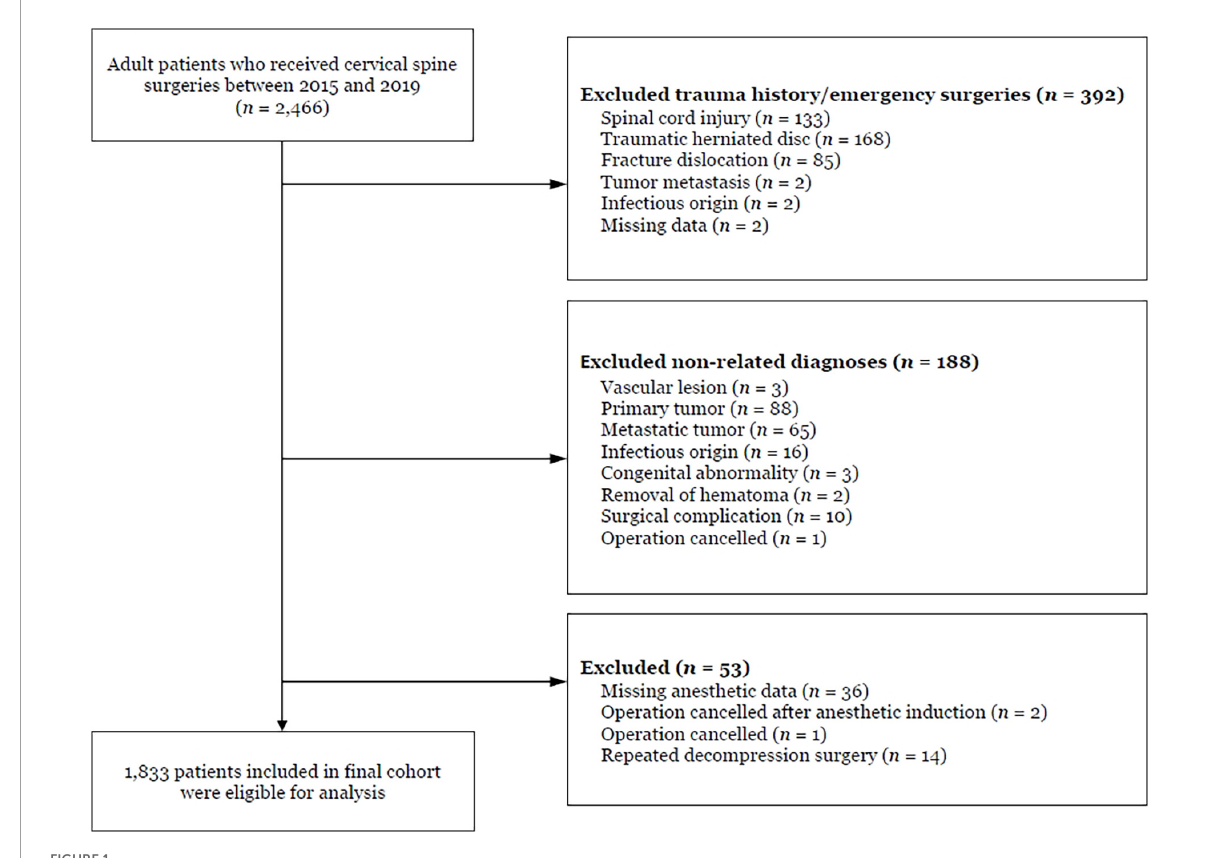
FIGURE1 Flow chart of patient